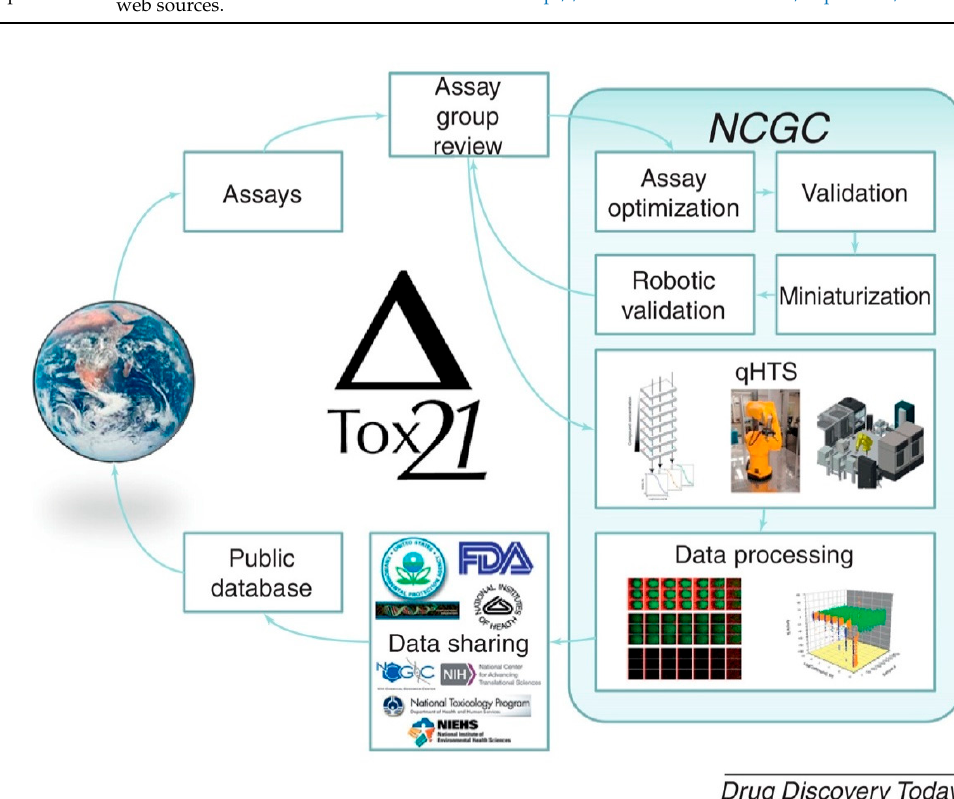
Figure 2. Tox21 screening workflow in drug discovery (qHTS: quantitative high-throughput screening; NCGC: NIH Chemical Genomics Center) [105].